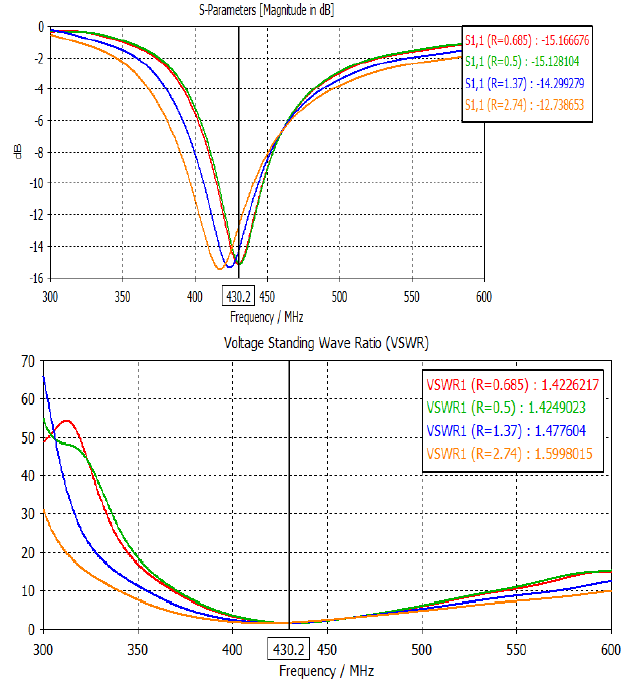
Fig. 6(a) and 6(b) depict the correlation between the dipole radius and its operating frequency; by increasing